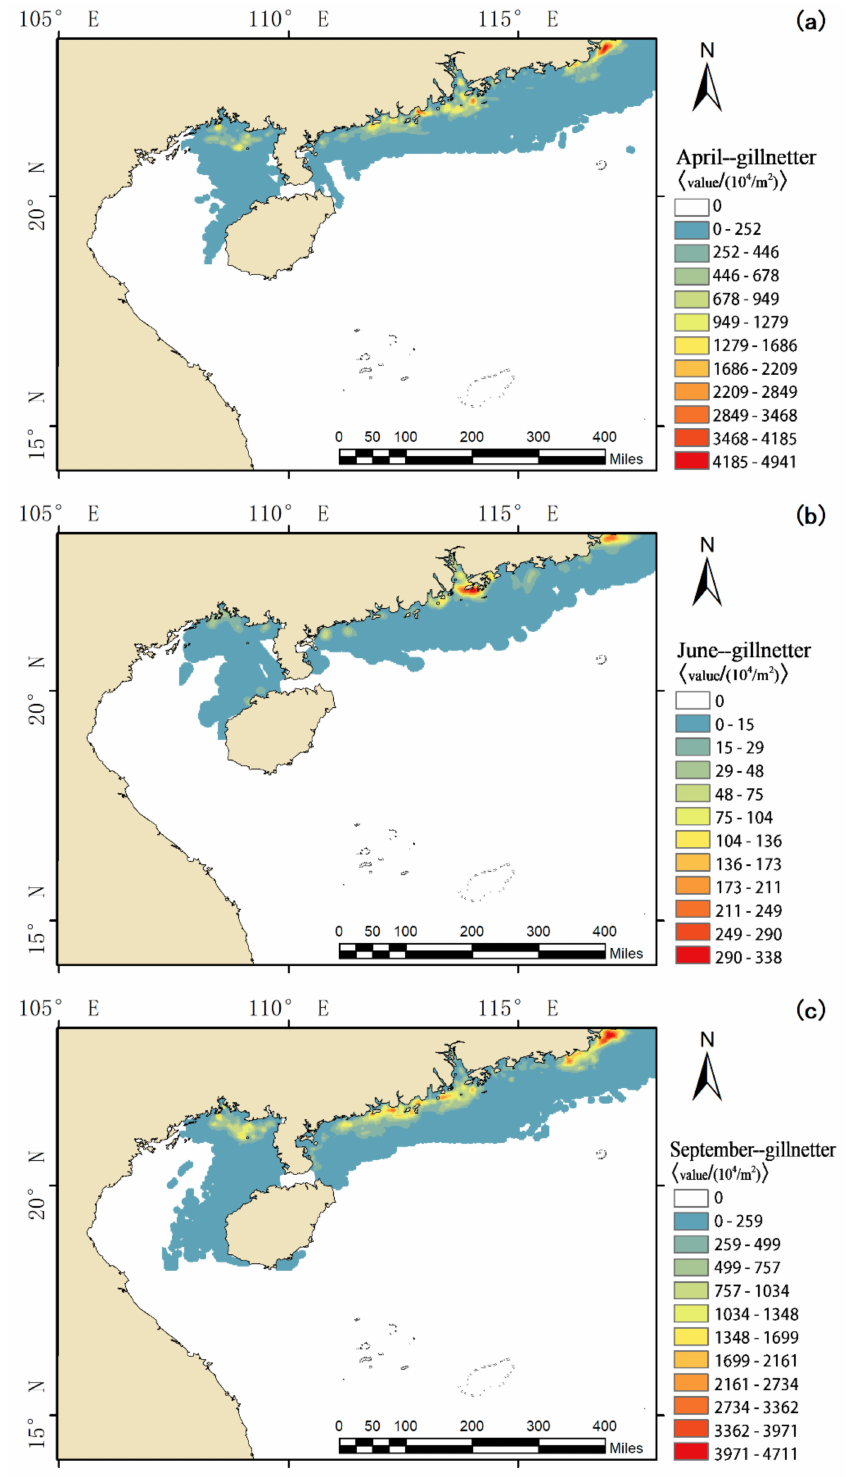
Figure 15. Nuclear density analysis chart of Chinese gillnetters in April ( a ), June ( b ) and September ( c